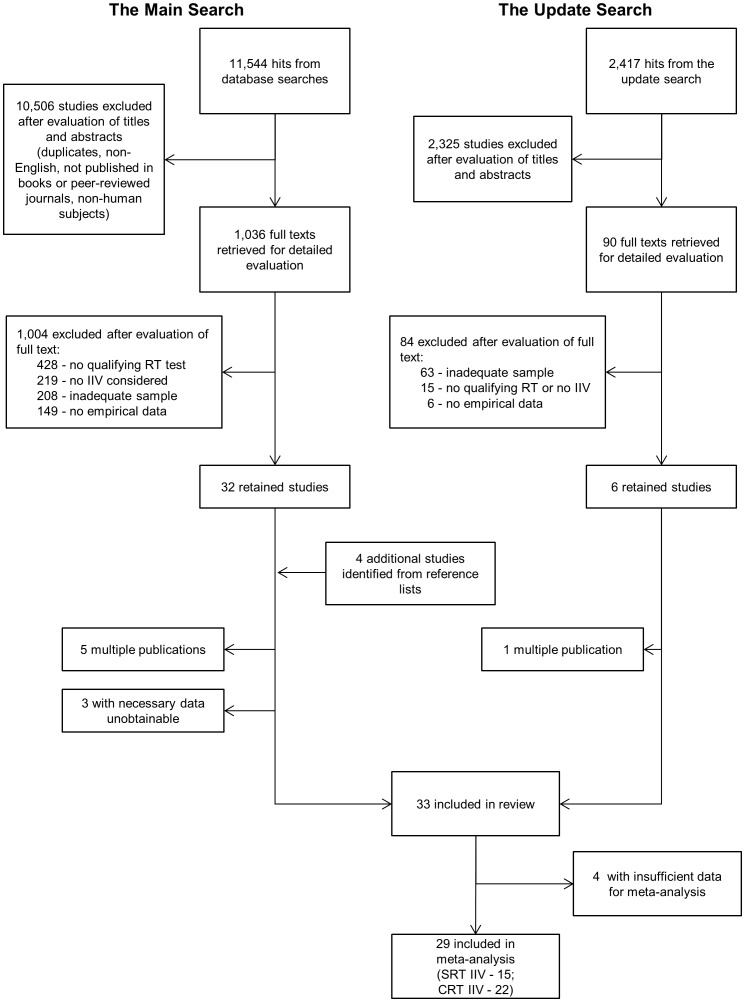
Flowchart of the review process.